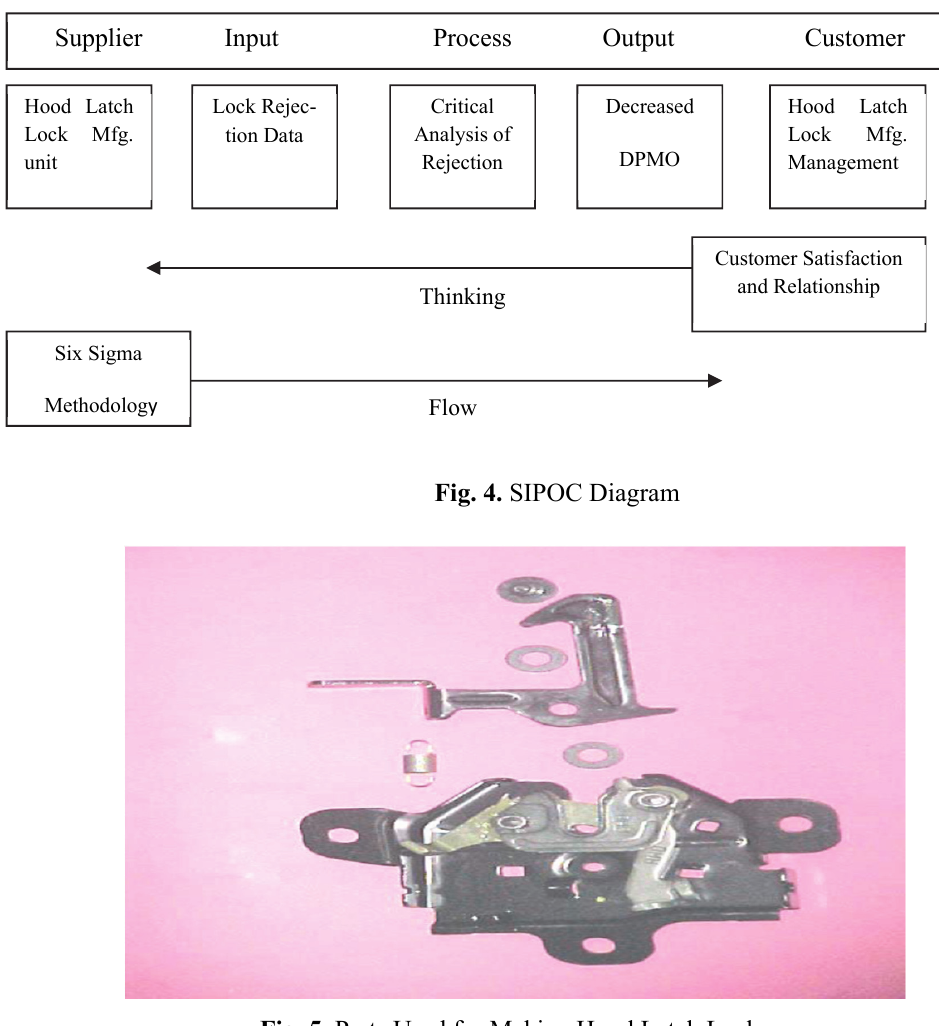
Fig. 5. Parts Used for Making Hood Latch